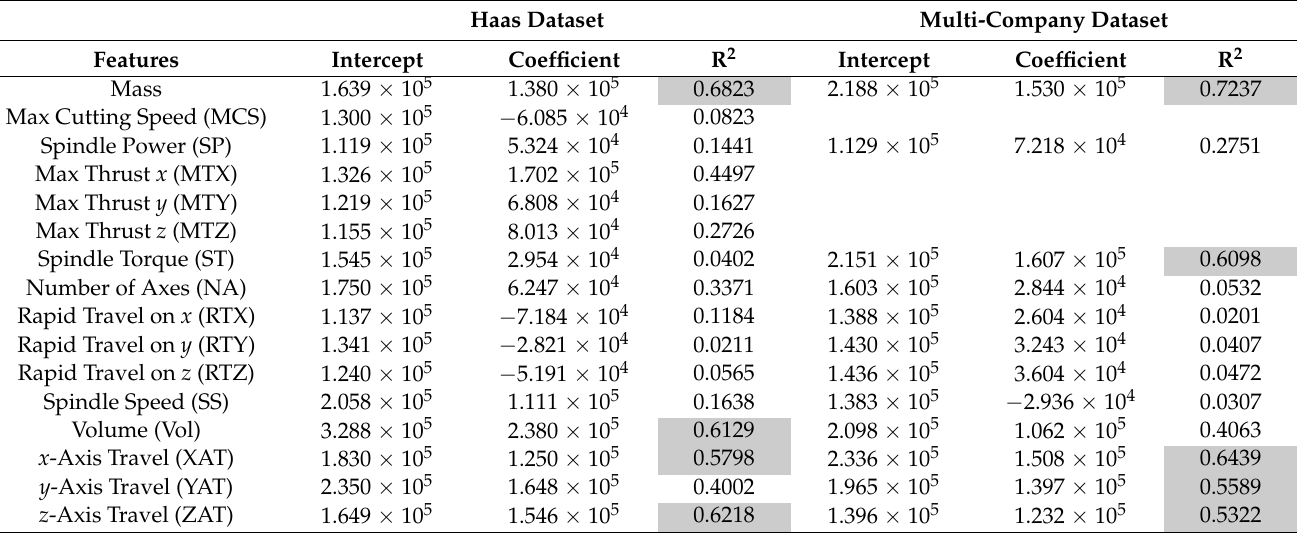
Table 2. Simple linear regression models including R 2 values for each feature, where the values greater than 0.5 are shaded (nomenclature shown in the Features column is used in Tables 3 and